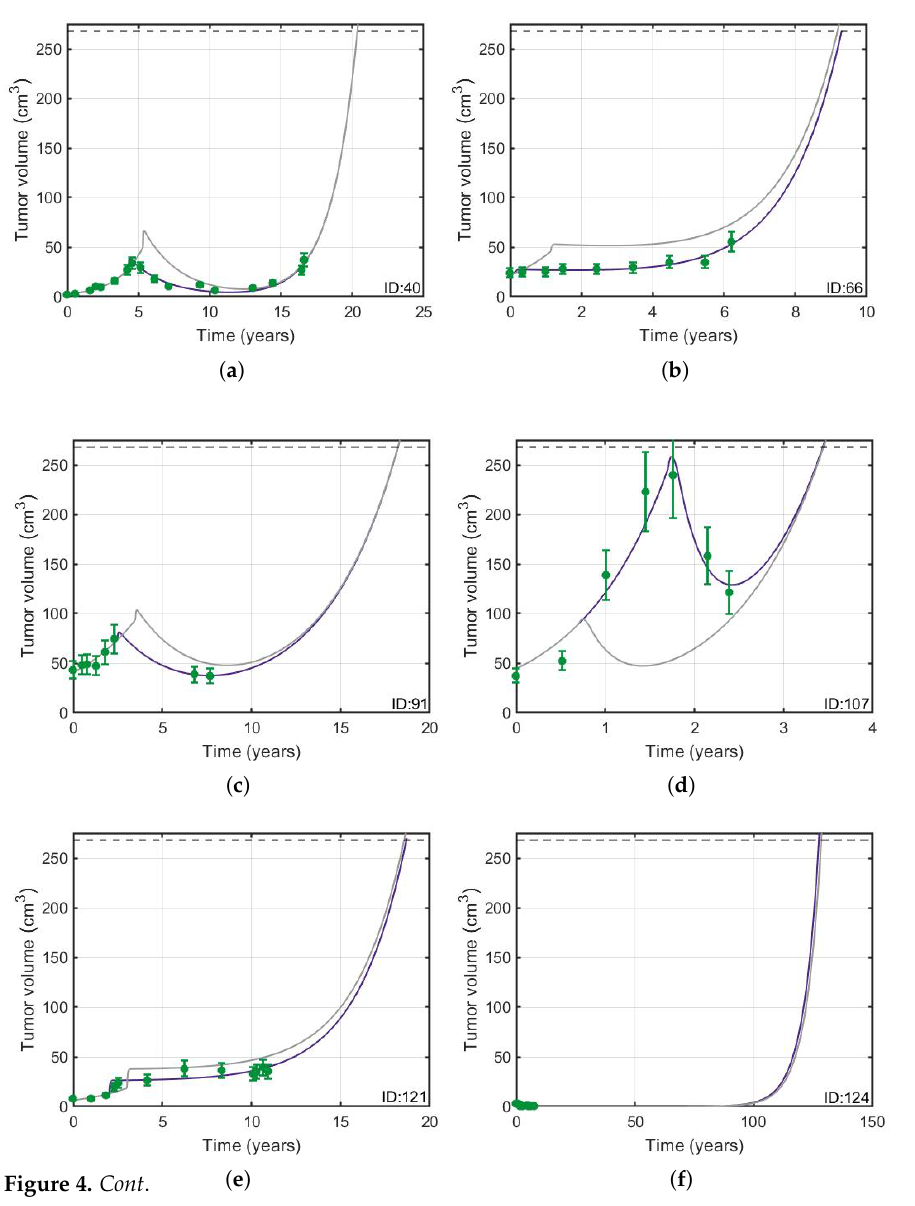
( f ) Figure 4. Cont